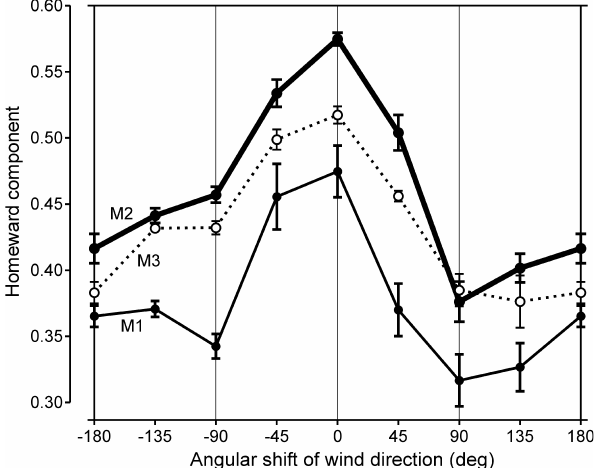
Fig. 4. Means ( ± 95% confidence limits) of uppermost 10 of 100 homeward components c H obtained with correct linkage of VOC data and wind data at home (0 ◦ ) and with wind directions shifted to the left (minus) or right (plus). M1, M2, M3 indicate phase B algorithm Mode 1, 2, 3, respectively. Data collected at distances 90–200km (M2 at 0 ◦ refers to an extra ItSeries of 100 ItRuns , not included in Supplement